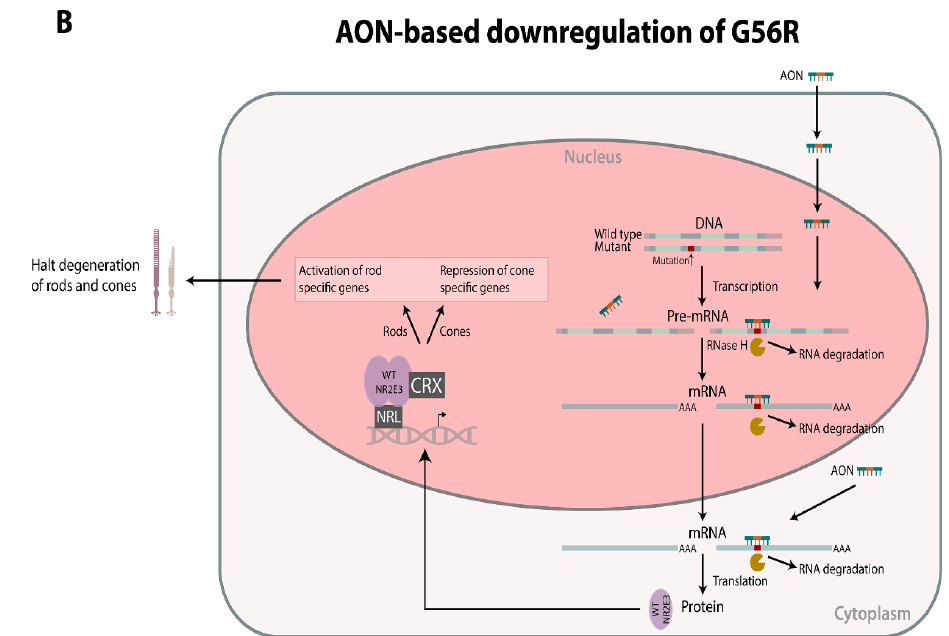
Figure 1. Schematic overview of the dominant negative effect of G56R Nuclear Receptor Subfamily 2 Group E Member 3 (NR2E3) ( A ) and allele-specific silencing of G56R using antisense oligonucleotides (AONs) ( B ). ( A ) Both wild type (WT) and mutant alleles are transcribed and translated. The wild type protein is able to form homo-dimers and bind the DNA, in complex with Neural Retina Leucine Zipper (NRL). The mutant protein is competing for binding with Cone-Rod Homeobox (CRX) and this complex is no longer able to bind the DNA, which leads to a failure of both potentiation of rod specific genes and activation of cone specific genes. ( B ) Using AONs, the mutant allele can be selectively downregulated, whereby the WT protein is binding the DNA in complex with both NRL and CRX. This complex is able to properly activate the rod specific genes and repress the cone specific genes, which would halt degeneration of the photoreceptors . Adapted from [18].